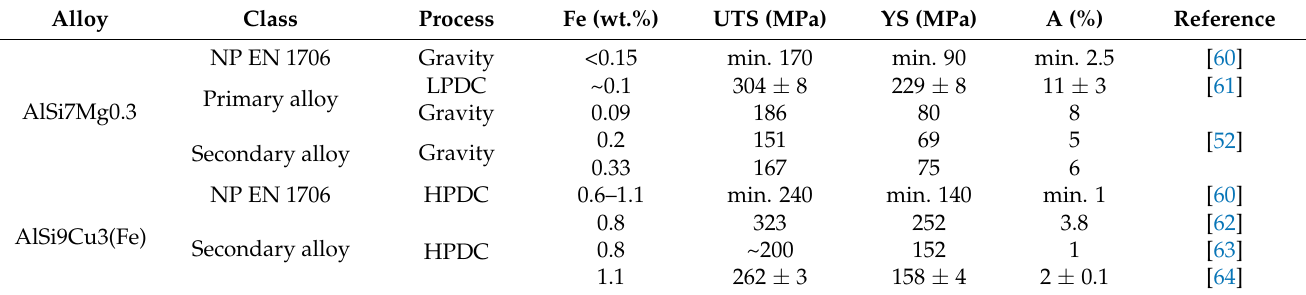
Table 3. The mechanical properties of primary and secondary casting